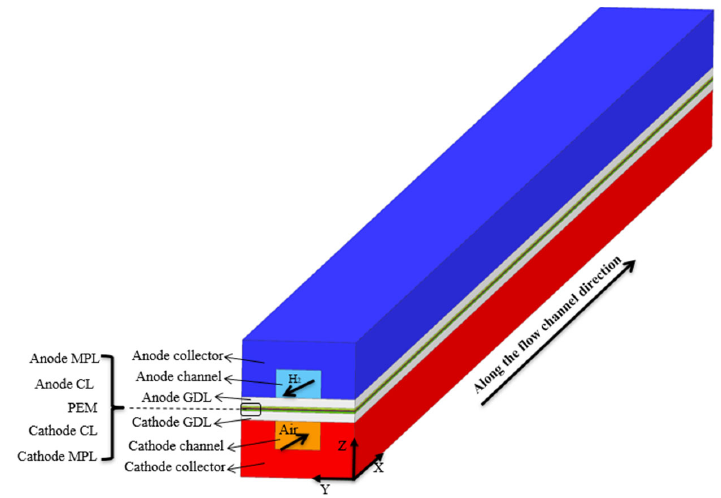
Figure 1. Schematic of the PEMFC